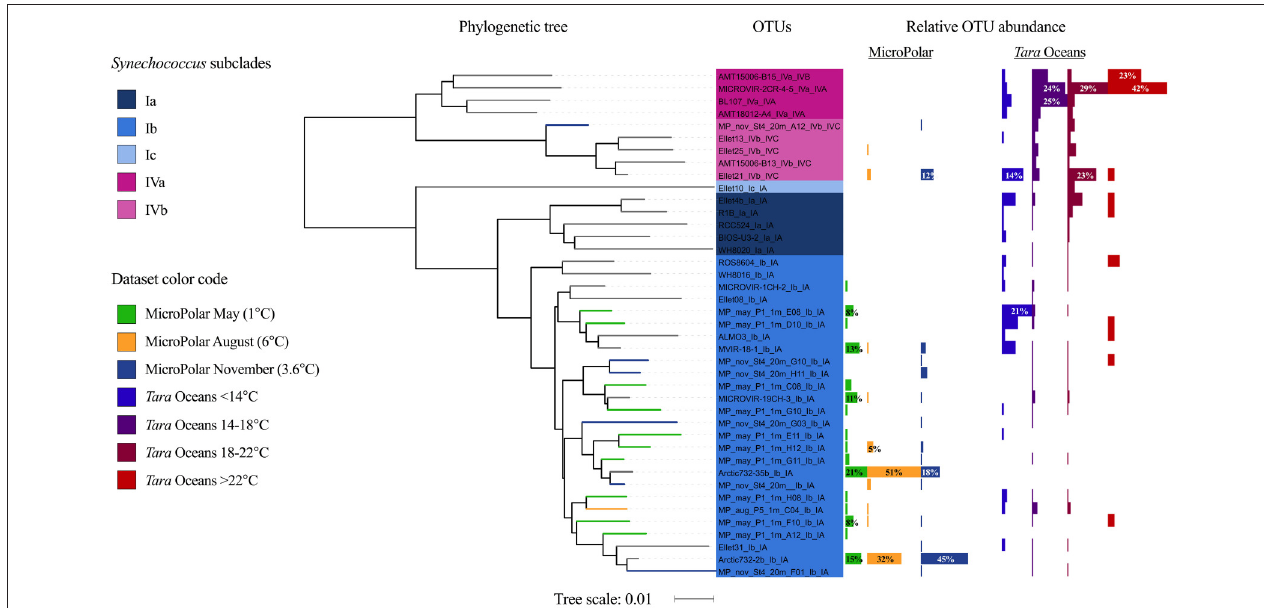
FIGURE 7 | (Left panel) Phylogenetic tree of the 41 petB OTUs at 97% ID, representative of the genetic diversity of Synechococcus within clades I and IV in the reference database (117 sequences) and in three MicroPolar samples (174 sequences). The colored thick branches indicate OTUs that are unique to the MicroPolar study (named MP_month_station_depth_) and colored according to the sampling month: May (green), August (orange) and November (blue). (Right panel) Relative abundance of the OTUs in each MicroPolar months (following the same color code as the branches) and in Tara Oceans stations grouped by surface water temperature ranges of the sampling site. The relative abundance is additionally given in percentage on selected